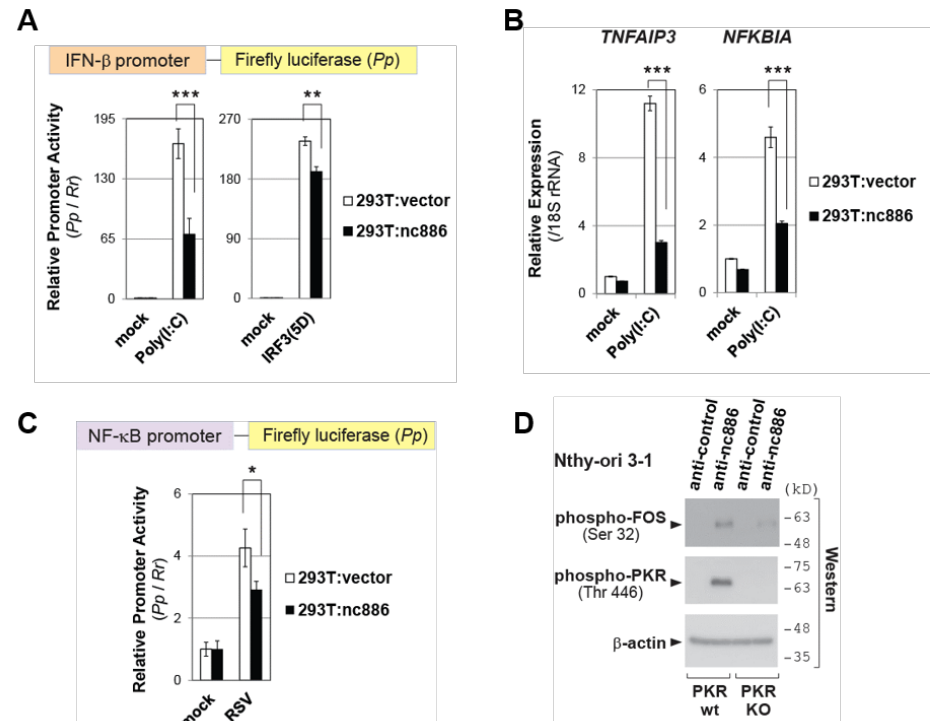
Figure 3. nc886 suppresses NF- κ B and AP-1, two PKR downstream pathways. ( A ) Luciferase assays. Poly(I:C)-HMW was used. Poly(I:C) or an IRF3(5D)-expressing plasmid was co-transfected with luciferase plasmids, followed by cell harvest at 24 h. All the other descriptions are the same as Figure 1D. ( B ) qRT-PCR measurement of indicated NF- κ B target genes, at 3 h after transfection of Poly(I:C). ( C ) Luciferase assays as described in Figure 1D. ( D ) Western blot of indicated proteins, as described in Figure 2B. Cells were harvest at 24 h after transfection of anti-oligos. One, two, and three asterisks designate a p -value less than 0.05, 0.01, and 0.001,